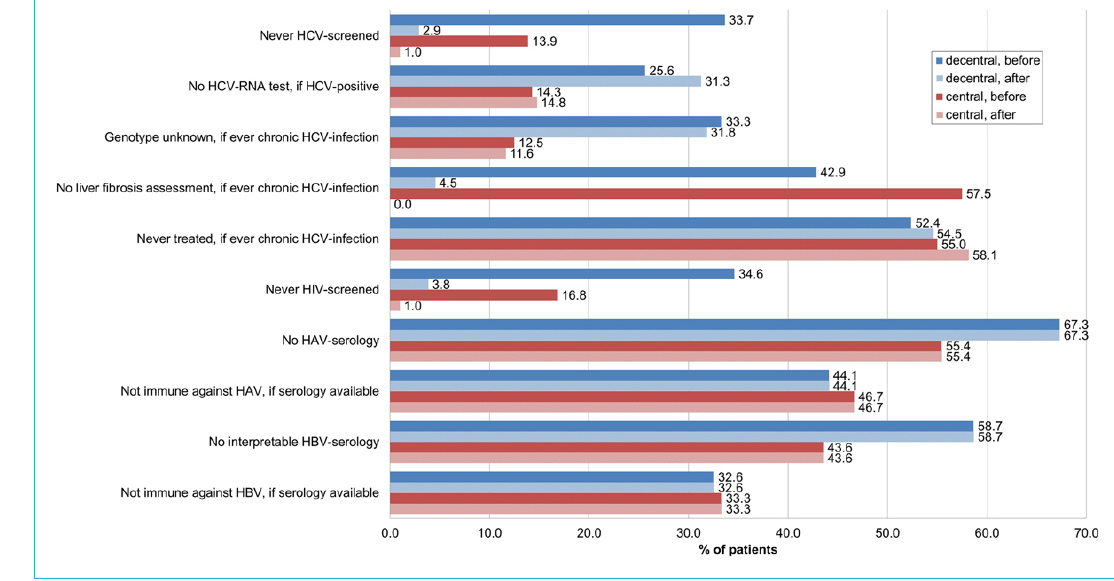
Figure 5: Noncompliance with guidelines according to place of recruitment – decentralised (n = 104) versus centralised setting (n = 101) – be- fore and after HCV rapid tests and Fibroscan ® within our study.HCV = hepatitis C virus; HIV = human immunodeficiency virus; HAV = hepatitis A virus; HBV = hepatitis B virus; decentral = decentralised setting (n=104); central = centralised setting (n=101); before = before HCV rapid tests and Fibroscan ® within our study; after = after HCV rapid tests and Fibroscan ® within our